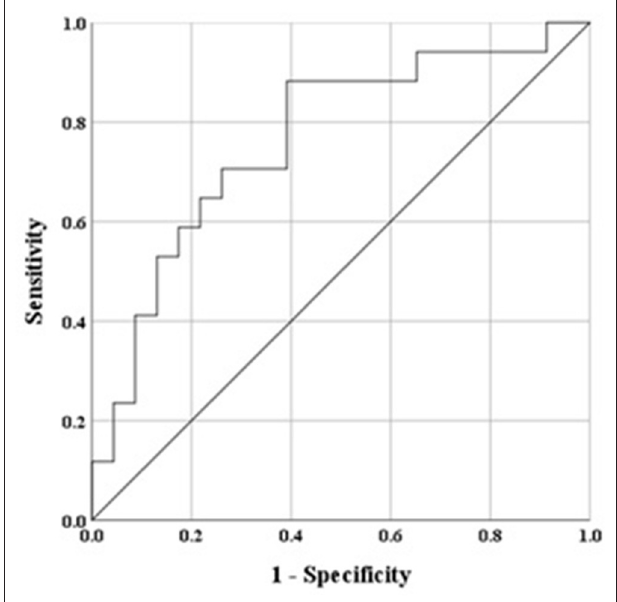
FIGURE 4 | Receiver operator characteristic (ROC) based on baseline variables to predict persistent AHR to mannitol, ROC curve final multivariate model, area under the curve (AUC) for the final model was 0.851, whereby a value of 0.5 indicates chance model performance and 1.0 indicates perfect performance. The model determined lower FEV 1 % predicted and FEV 1 /FVC, and higher FEF 25 − 75 % % predicted and RDR 100 %/mg baseline variables as predictors of persistence of AHR to mannitol after 20 weeks daily treatment with